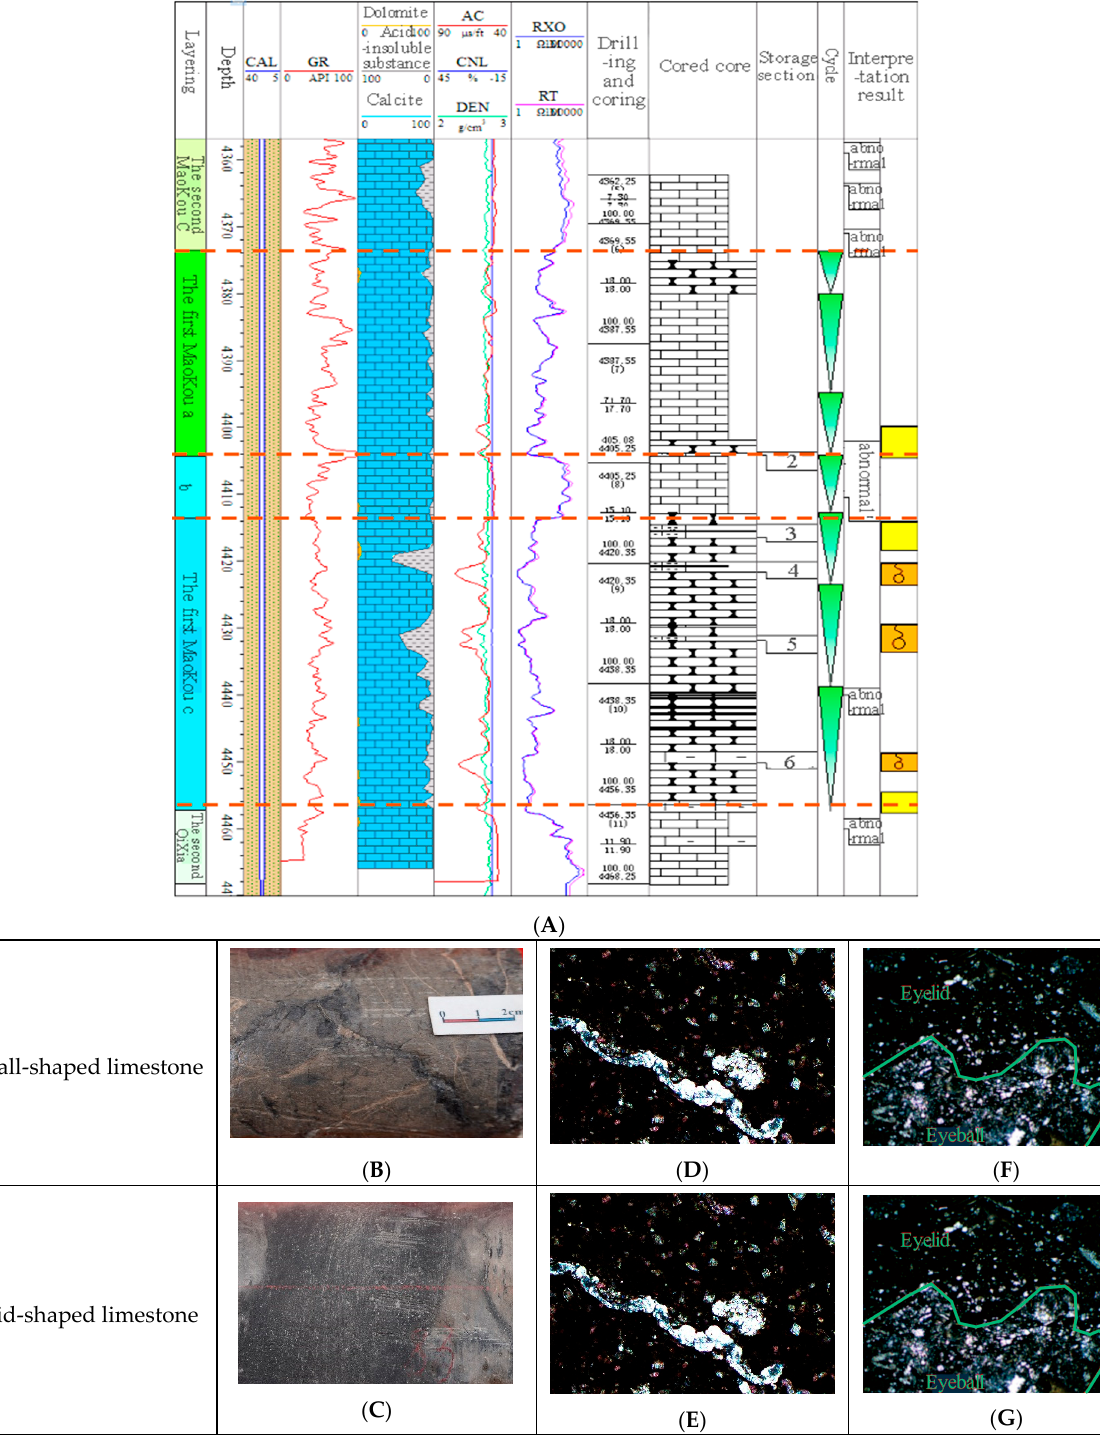
Figure 2. Comprehensive lithological histogram of the first member of Maokou Formation of the Xintan Well 1. ( A ). Comprehensive lithological histogram of the Xintan Well 1. ( B ). The lower member b of the first member of Maokou Formation 4407.65 m. ( C ). The lower member c of the first member of Maokou Formation 4454.65 m. ( D ). The lower member c of the first member of Maokou Formation 4420.52 m. ( E ). The lower member c of the first member of Maokou Formation 4420.52 m. ( F ). The lower member c of the first member of Maokou Formation 4451.30 m. ( G ). The lower member c of the first member of Maokou Formation 4451.30 m.